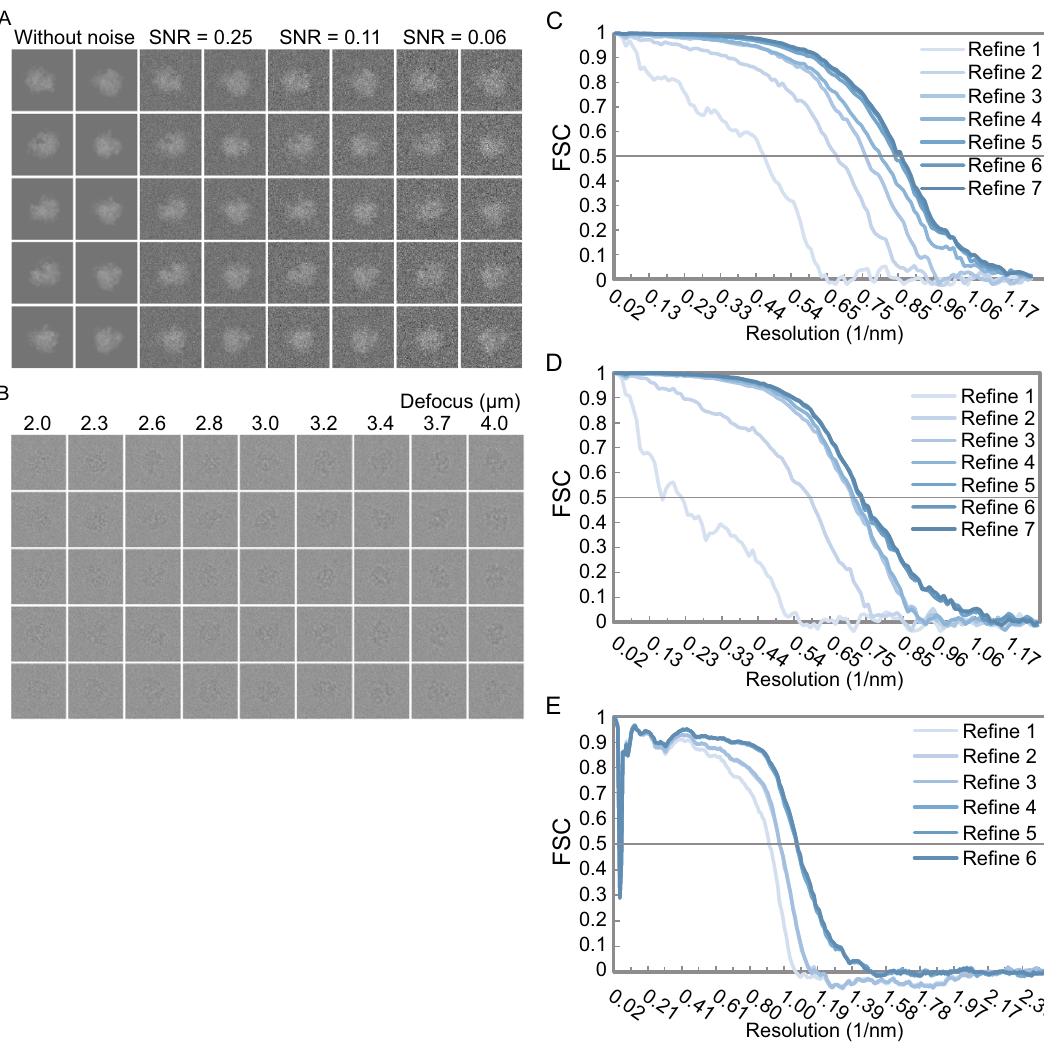
Figure 4. Simulated datasets and their FSC convergences during reconstruction re fi nements by conventional SPA procedure. (A) Every two columns represent the simulated projections of arti fi cial ribosome with Gaussian noise added in different SNR levels. The left two columns represent the original projections. (B) Simulated projections of arti fi cial ribosome generated from InSilicoTEM (Vulovic et al., 2013) in different defocus from − 2.0 μ m to − 4.0 μ m. (C), (D) and (E) The FSC curves of those simulated datasets ((C) is for the dataset in (A) with SNR of 0.25, (D) for the one in (A) with SNR of 0.11 and (E) for the one in (B)) during reconstruction re fi nement iterations by conventional SPA procedure. The FSC was calculated between the reconstructed map and the ground-truth map generated from PDB fi les (PDB code 4V7H for the datasets with Gaussian noise in (A), and PDB codes 4V7C for the dataset generated from InSilicoTEM in (B)). The fi nal assessed resolutions at FSC = 0.5 by the conventional SPA procedure are indicated and also shown in Table